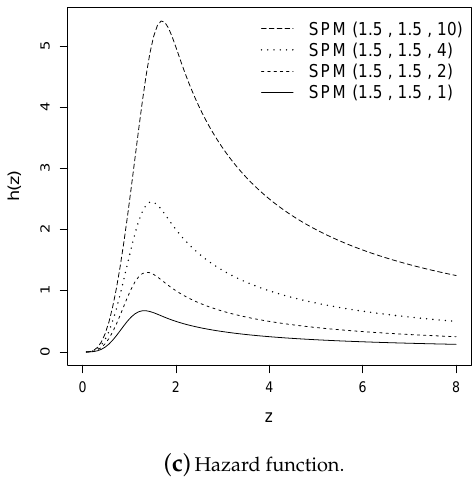
Figure 2. Plots of the distribution function, survival function and hazard function for the SPM (1.5, 1.5, q